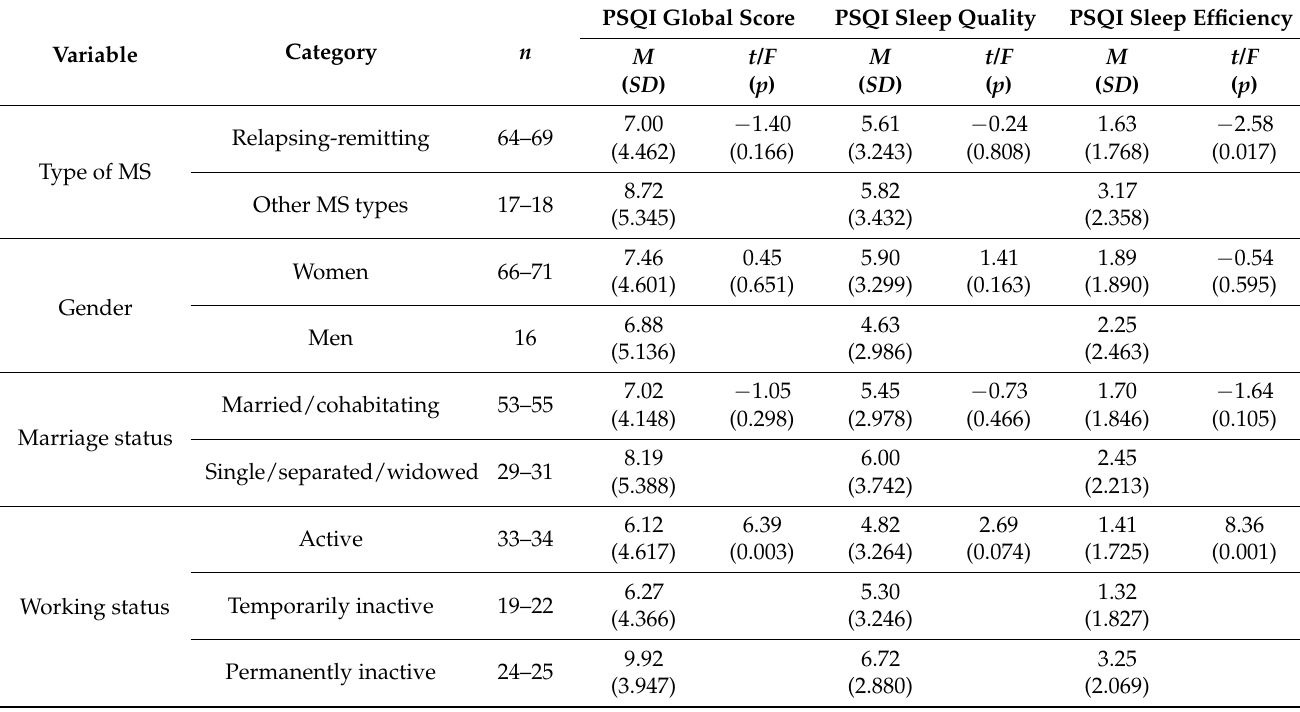
Table 9. Differences in PSQI scores regarding specific characteristics of